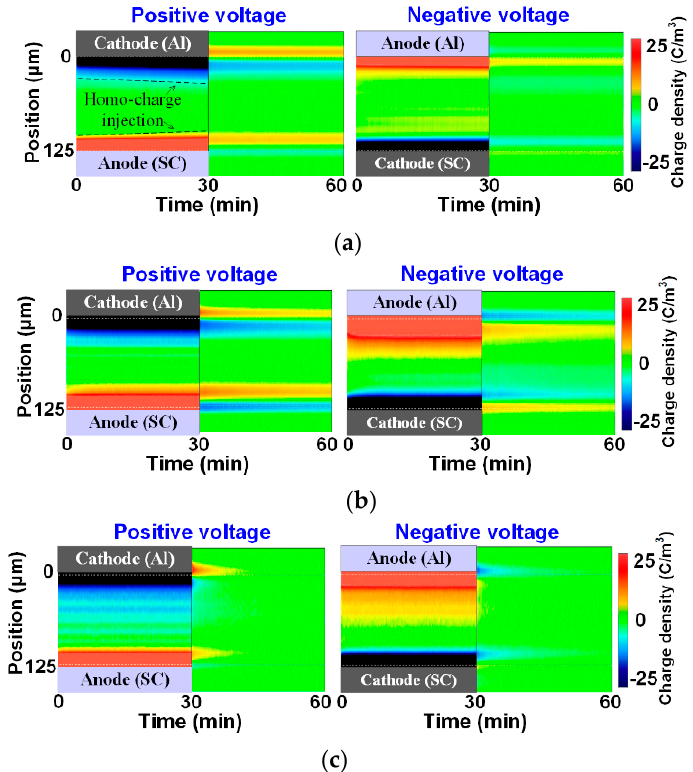
Figure 5. Space charge distributions under DC voltages: ( a ) room temperature, ( b ) 50 ◦ C, ( c ) 80 ◦